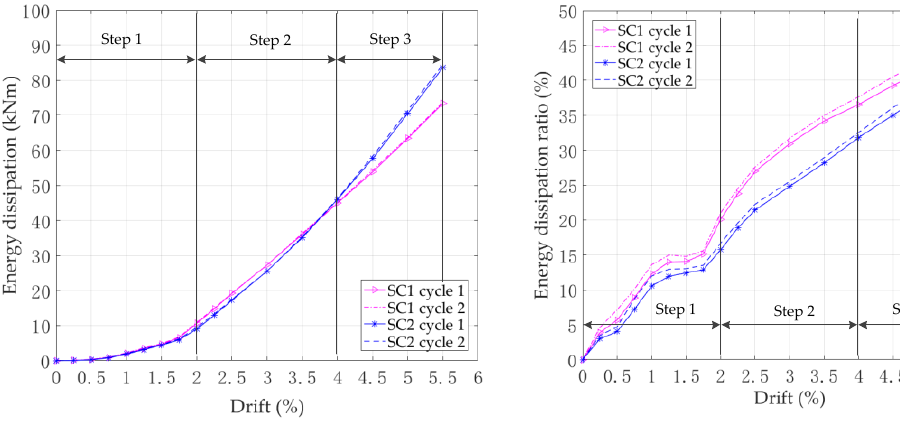
Figure 14. Energy dissipation for each cycle.